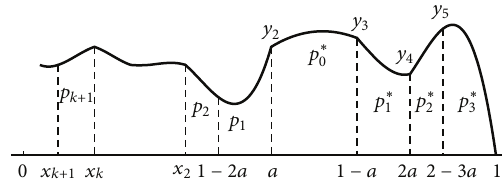
Figure 11: Illustration for Proposition